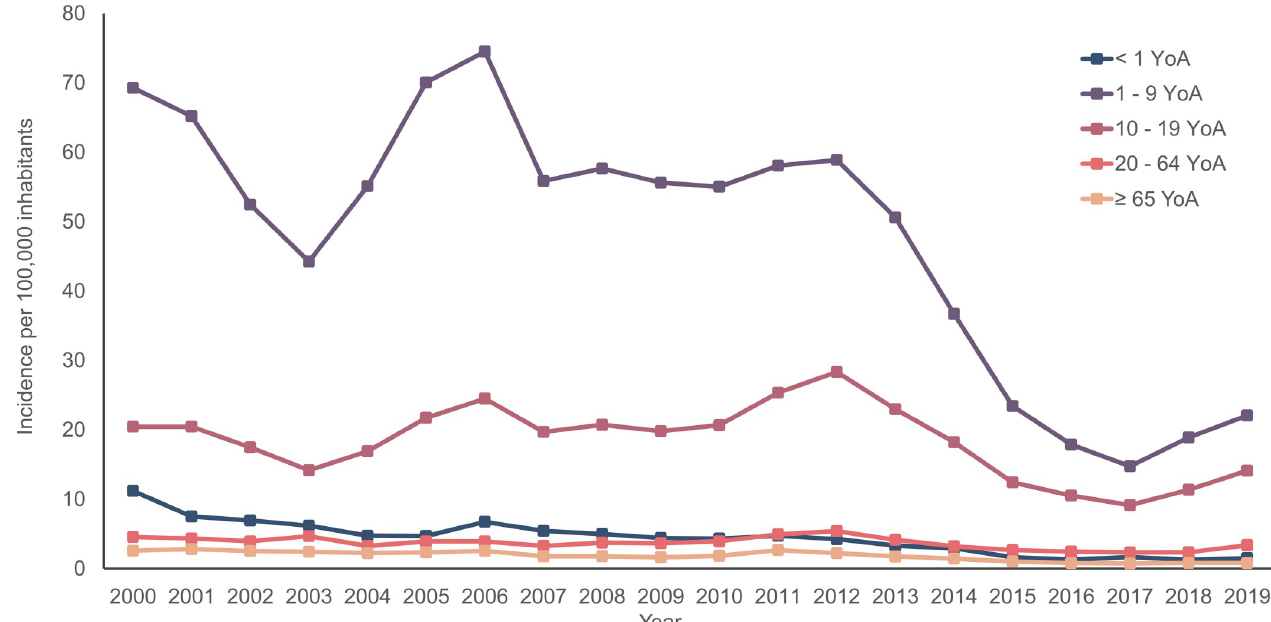
Fig 2. Incidence rate for diagnosed/detected HAV cases by age group and year. YoA: Years of age.